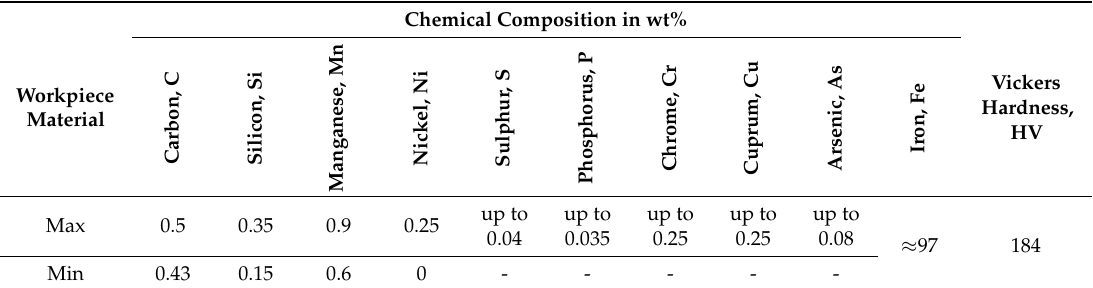
Table 1. Chemical composition and hardness of SAE 1045 steel.